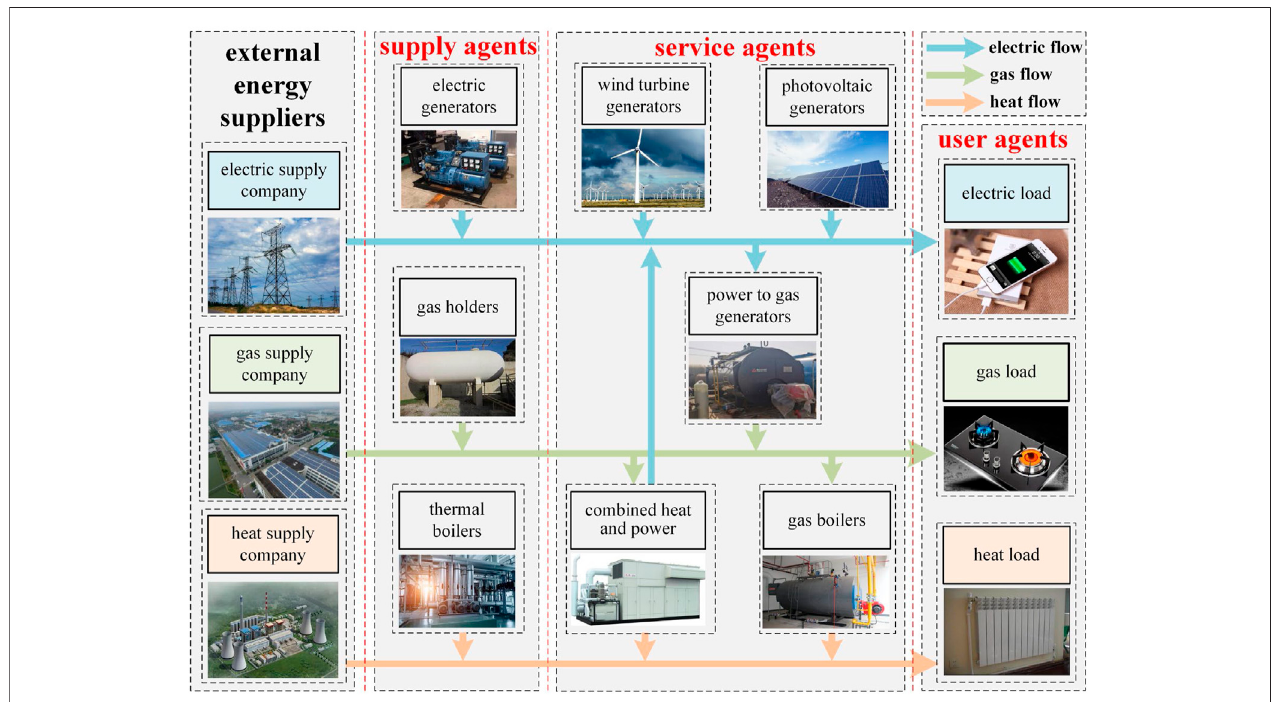
FIGURE 1 | Regional energy